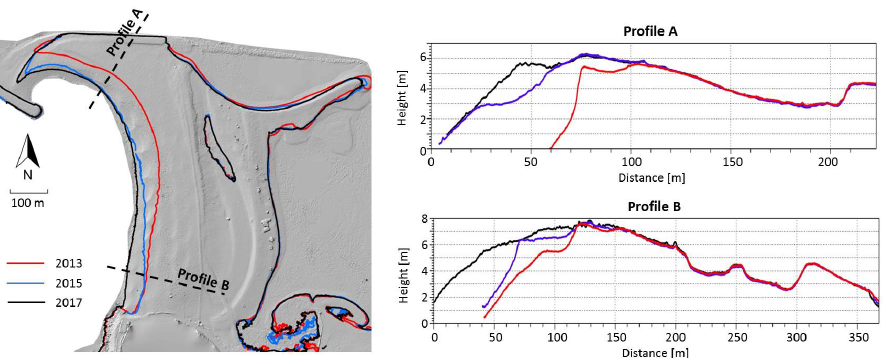
Figure 8. Profiles along the steepest slope, in the part of largest sand increase for the three epochs: red for 2013, blue for 2015, and black for 2017. Profile A had larger increase from 2013 to 2015, while in profile B the largest increase was from 2015 to